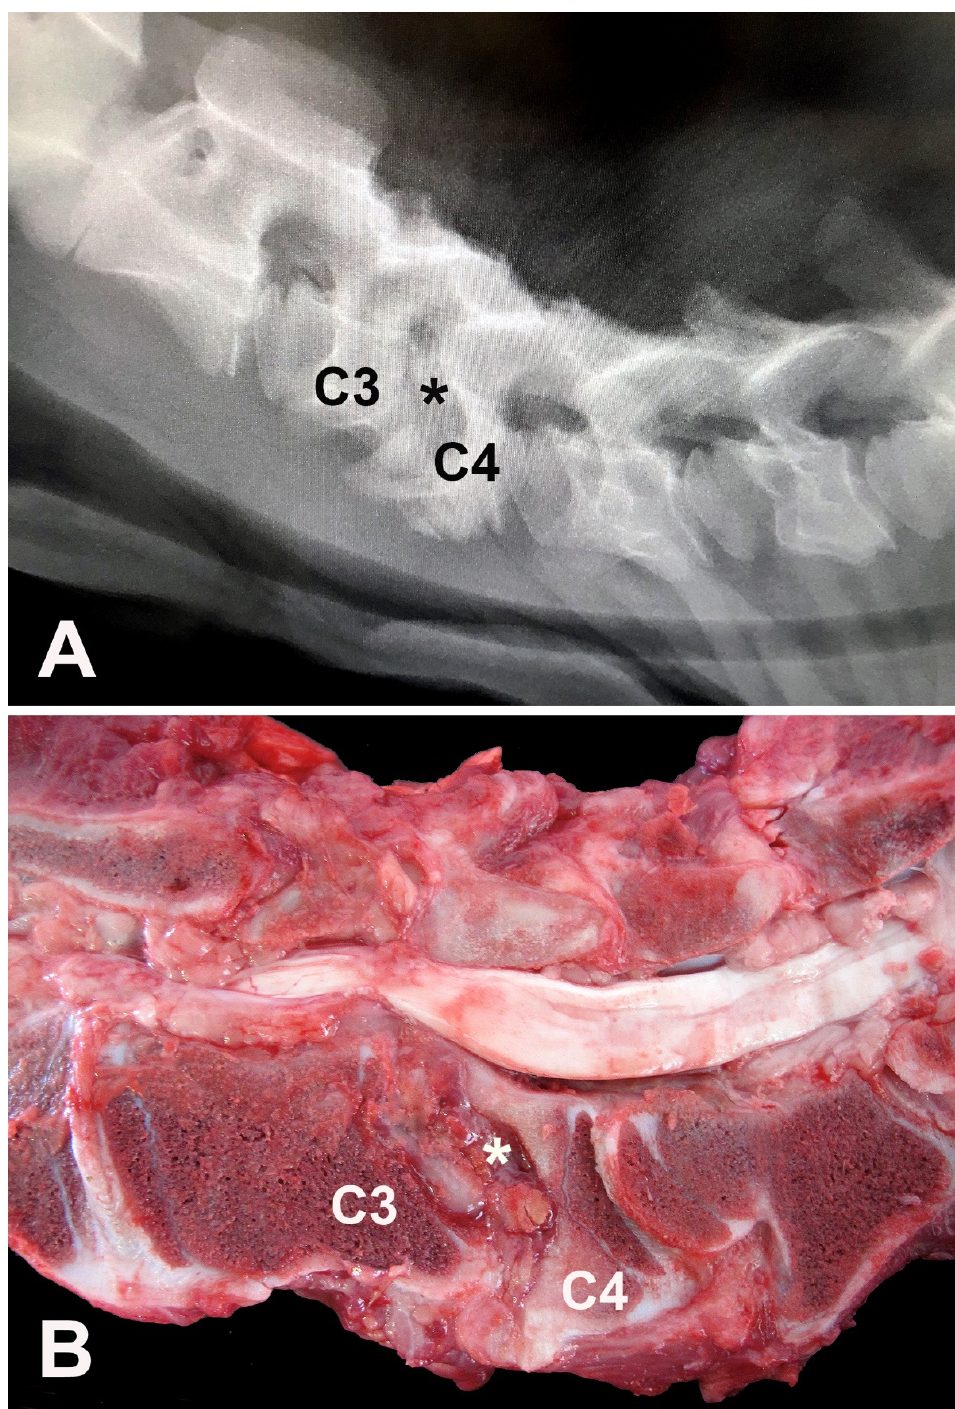
Figure 1. Four-month-old Nelore calf. ( A ) Latero-lateral digital radiograph of the cervical vertebral column showing intervertebral foramina with altered radiopacity, reduced intervertebral spaces, and misalignments between the endplates, more evident between the C3 and C4 vertebrae (asterisk) with material displacing the spinal cord ventri-dorsally and almost completely obliterating the corresponding intervertebral foramen, resulting in narrowing of the spinal canal and compression of the spinal cord. ( B ) Cervical vertebrae, longitudinal section, gross aspect. C3–C4 vertebrae misalignment (asterisk), reduced C4 vertebral body size and deformity, and focal compression of the cervical spinal